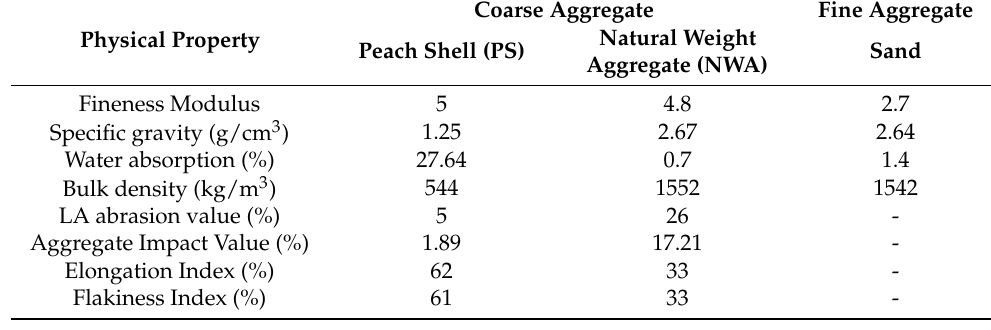
Table 2. Physical properties of peach shell, coarse and fine aggregates.